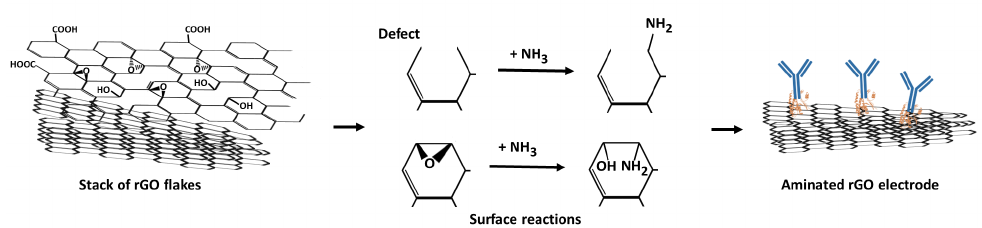
Figure 3. Schematic of the possible surface reactions that may occur on the rGO electrode after incubation in ammonium hydroxide. These reactions would lead to the presence of amine functional groups on the